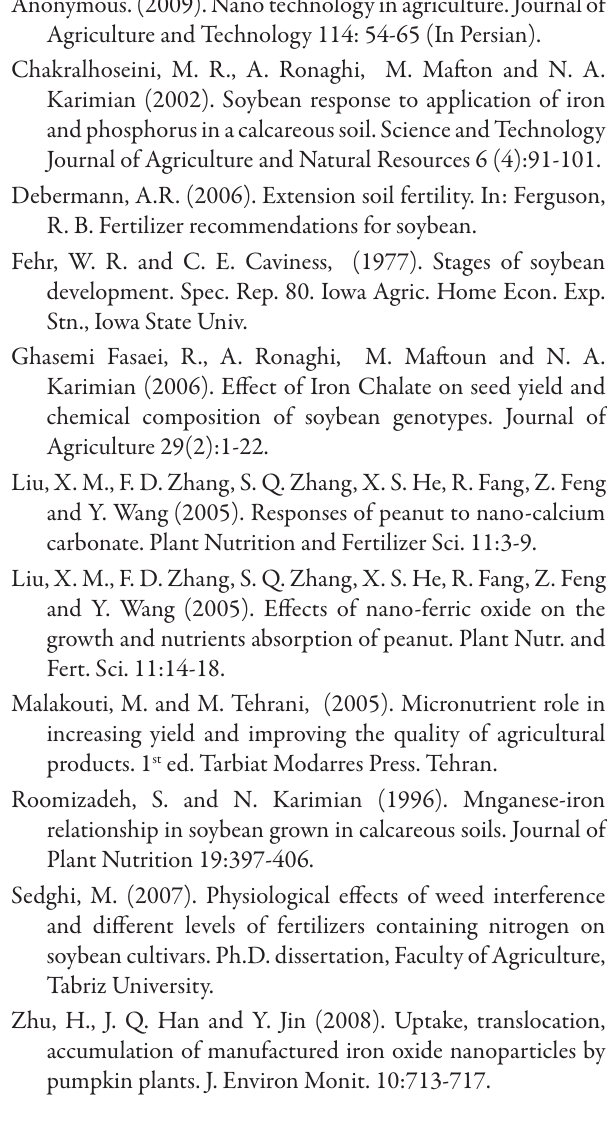
Tab. 2. Effect of various concentrations of nano-iron oxide on some agronomic traits in soybean